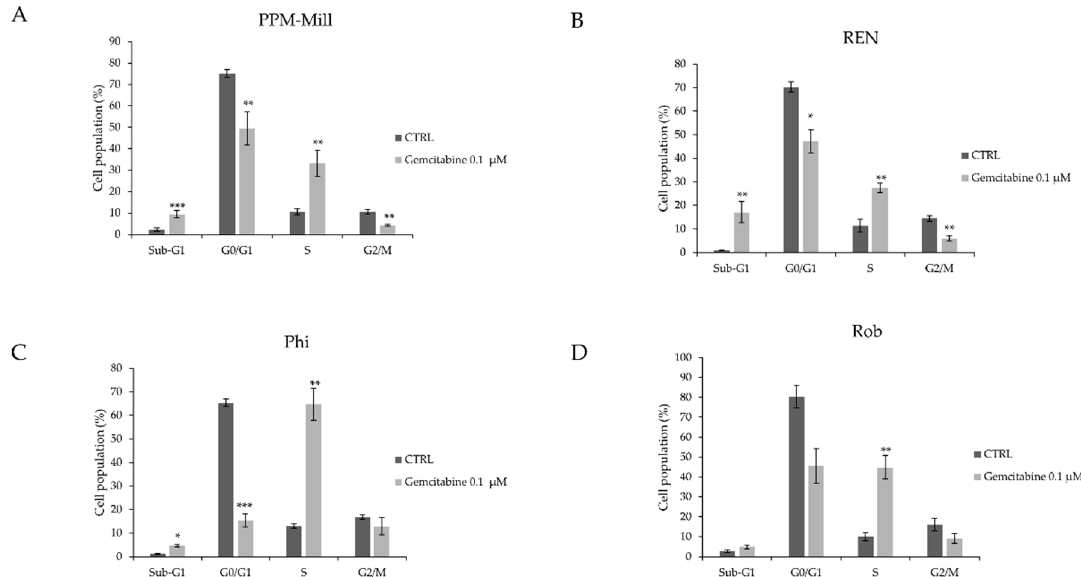
Figure 2. Cell cycle progression analysis in human mesothelioma cells with WT, mutated BAP1 ( A – D ) treated with either 0.1 µM gemcitabine or with DMSO that was used as vehicle (CTRL) for 48 h, carried out using FACS). Statistical analysis is described in Materials and Methods section. * p ≤ 0.05, ** p ≤ 0.01, *** p ≤